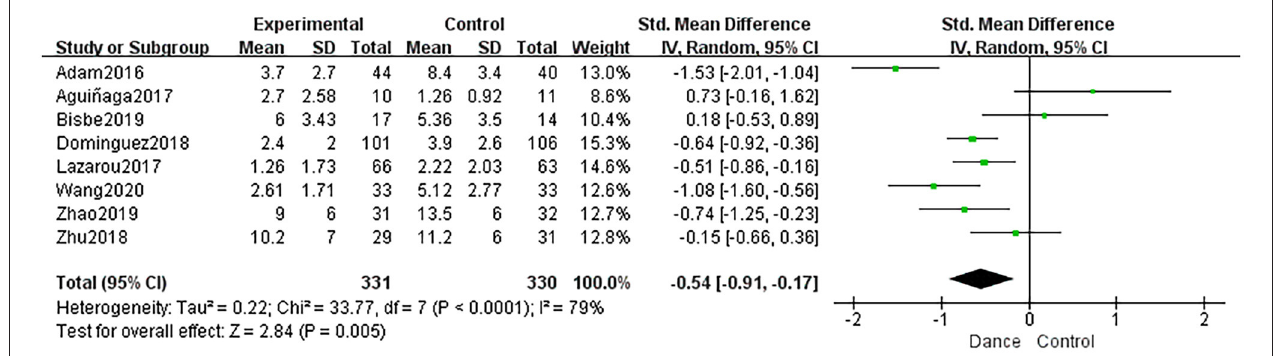
FIGURE 10 | Forest plot of depression results of dance group vs. control